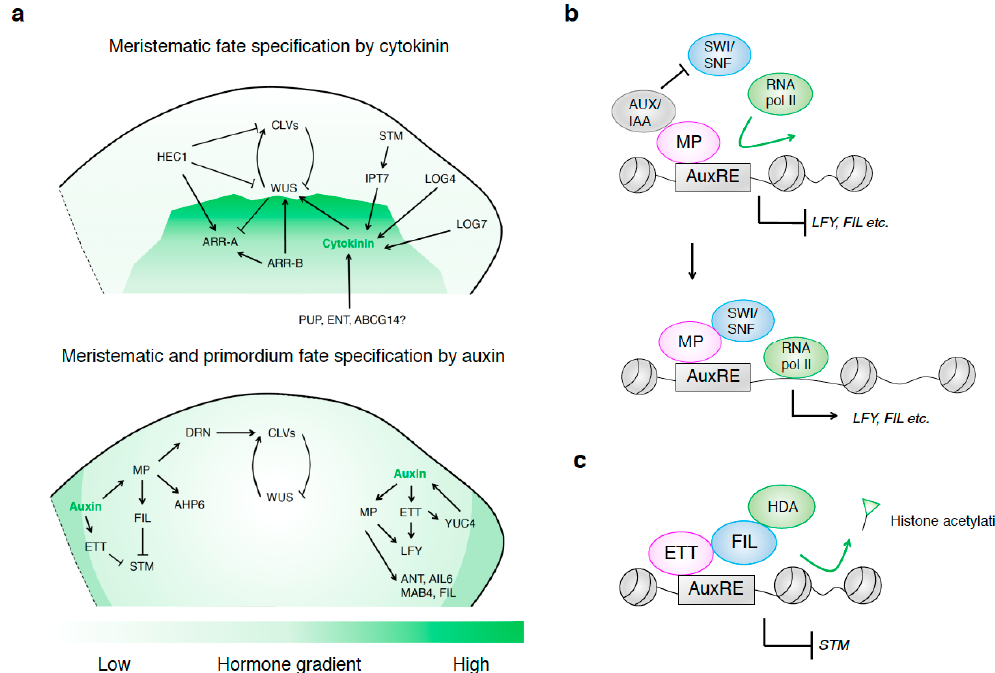
Figure 2. Hormonal control of the SAM to specify meristematic and primordium fate. ( a ) Top: Cytokinin-mediated SAM regulatory network for meristematic fate specification. Bottom: Auxin-mediated SAM regulatory network for meristematic and floral primordium fate specification. Green indicates hormonal gradients. The arrows represent the activation of gene expression, while the flat arrows represent its repression. ( b ) Chromatin state switch for primordium specification by the ARF5 / MP complex in response to auxin. The arrows represent the activation of gene expression, while the flat arrows represent its repression. ( c ) Chromatin state switch for primordium specification by ARF3 and the FIL complex. The arrows represent the activation of gene expression, while the flat arrows represent its repression.